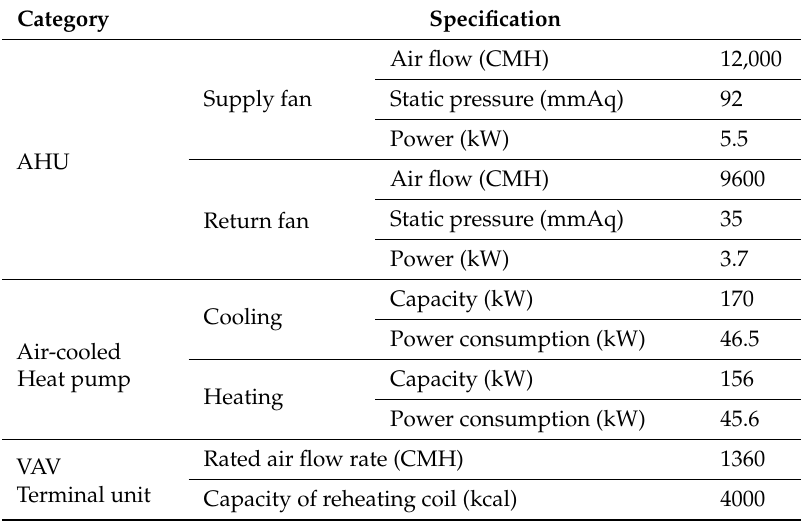
Table 1. Summary of test